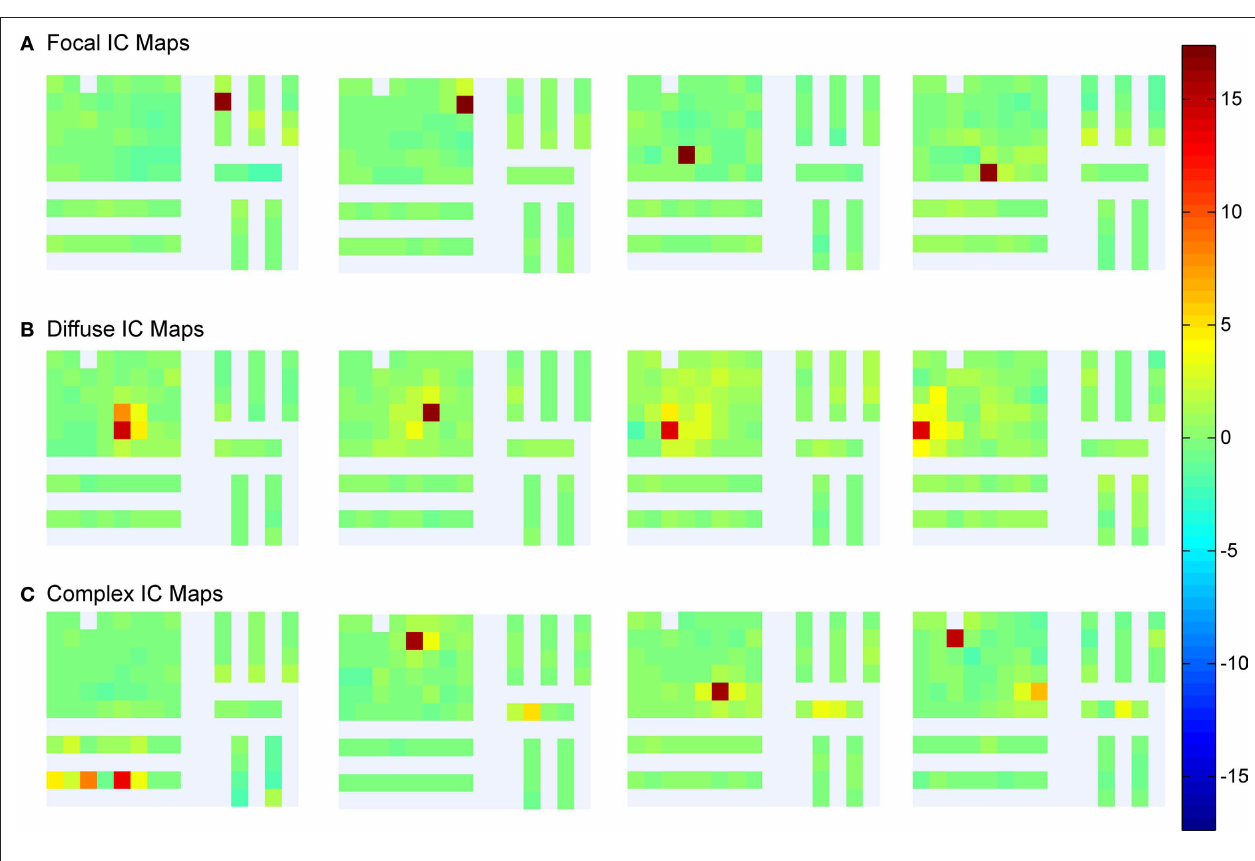
more focal current sources distal from the grid, or synchronous activity of a wider domain of cortex proximal to the implanted grid. (C) Set of components that project to widely separated electrode channels.